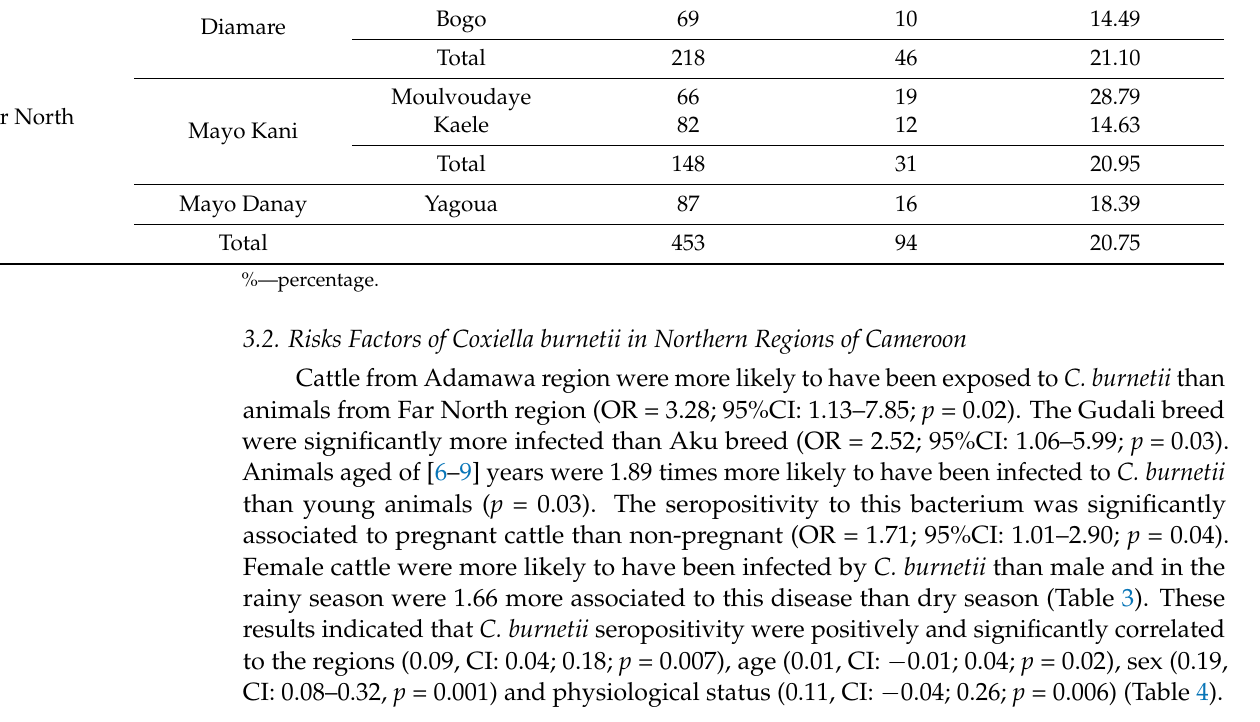
Table 3. Results of logistic regression analysis for risk factors identification for C. burnetii infection among slaughterhouse zebu cattle ( n = 2016) in Northern Regions of